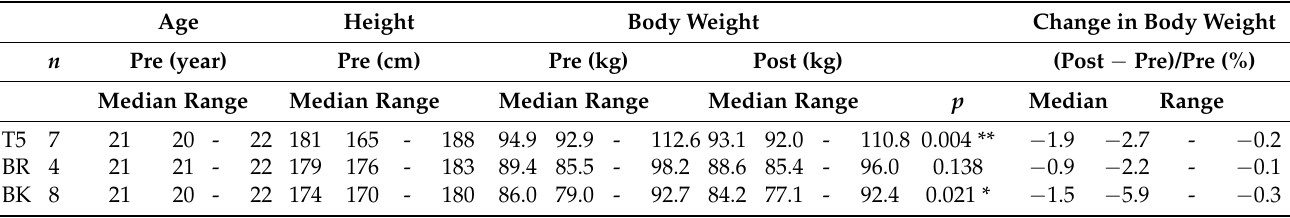
Table 1. Characteristics of the